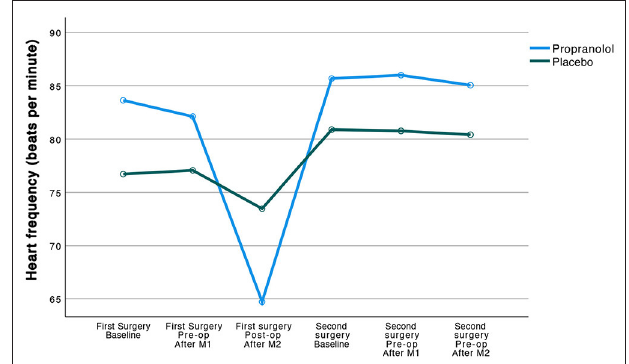
FIGURE 2 | Observed trajectories of the heart frequency (beats per minute) as a function of treatment